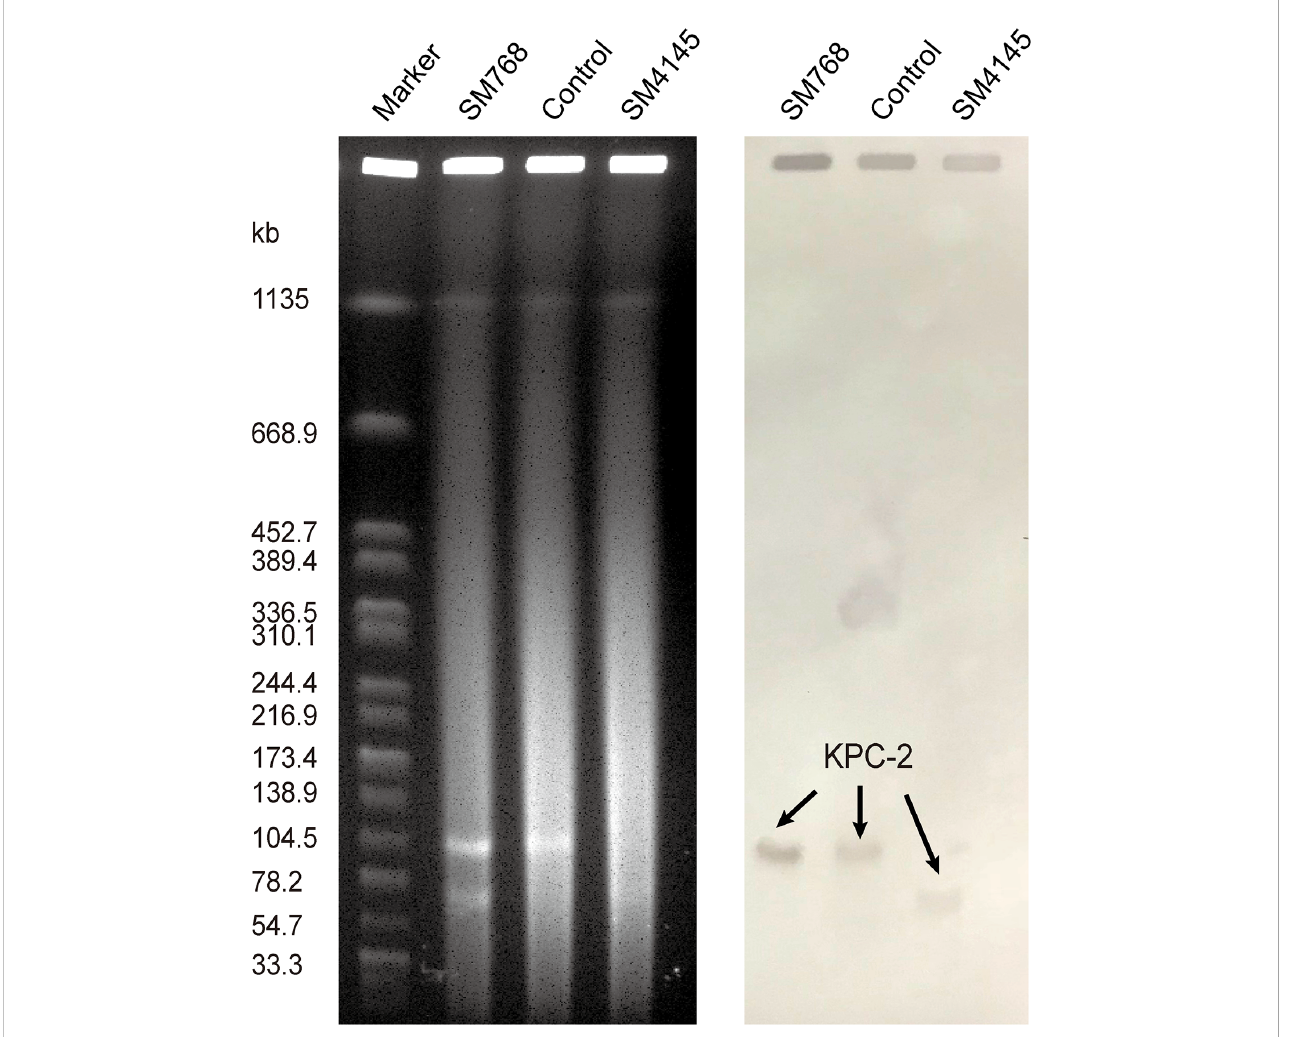
FIGURE 1 S1-PFGE analysis of KPC-2-producing S. marcescens isolates and southern hybridization using a bla KPC-2 probe. Lane M, molecular weight marker Salmonella Braenderup H9812; Lane SM768, isolate S. marcescens SM768; Lane control, KPC-2-producing Klebsiella pneumoniae isolate 1095 served as the control; Lane SM4145, isolate S. marcescens